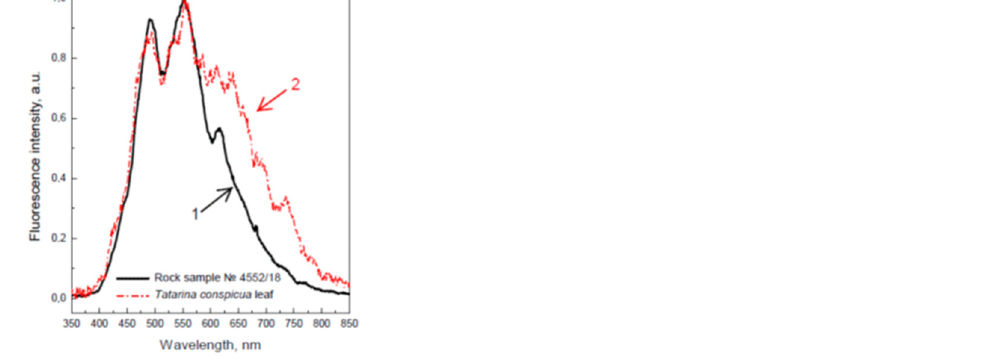
Figure 4. Laser fluorescence spectra of (1) rock sample No 4552/18 and (2) fossilized material of Tatarina conspicua leaf (the same sample No 4552/18).